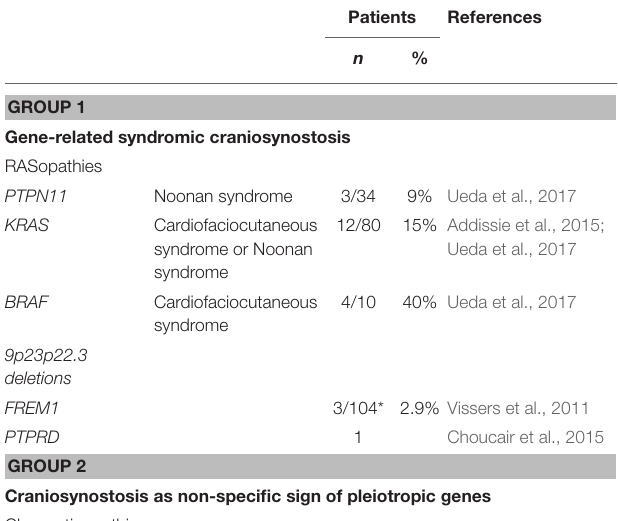
TABLE 1 | Examples of unusual syndromic forms of craniosynostosis reflecting the pathogenic role of new candidate genes (Group 1) or nonspecific effects of pleiotropic genes (Group